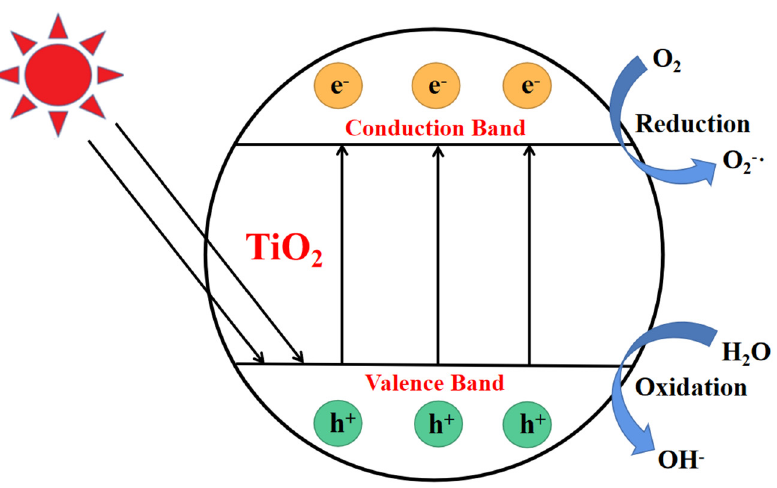
Figure 1. Photocatalytic formation mechanism of electron − hole pair in a semiconductor TiO 2 particle .